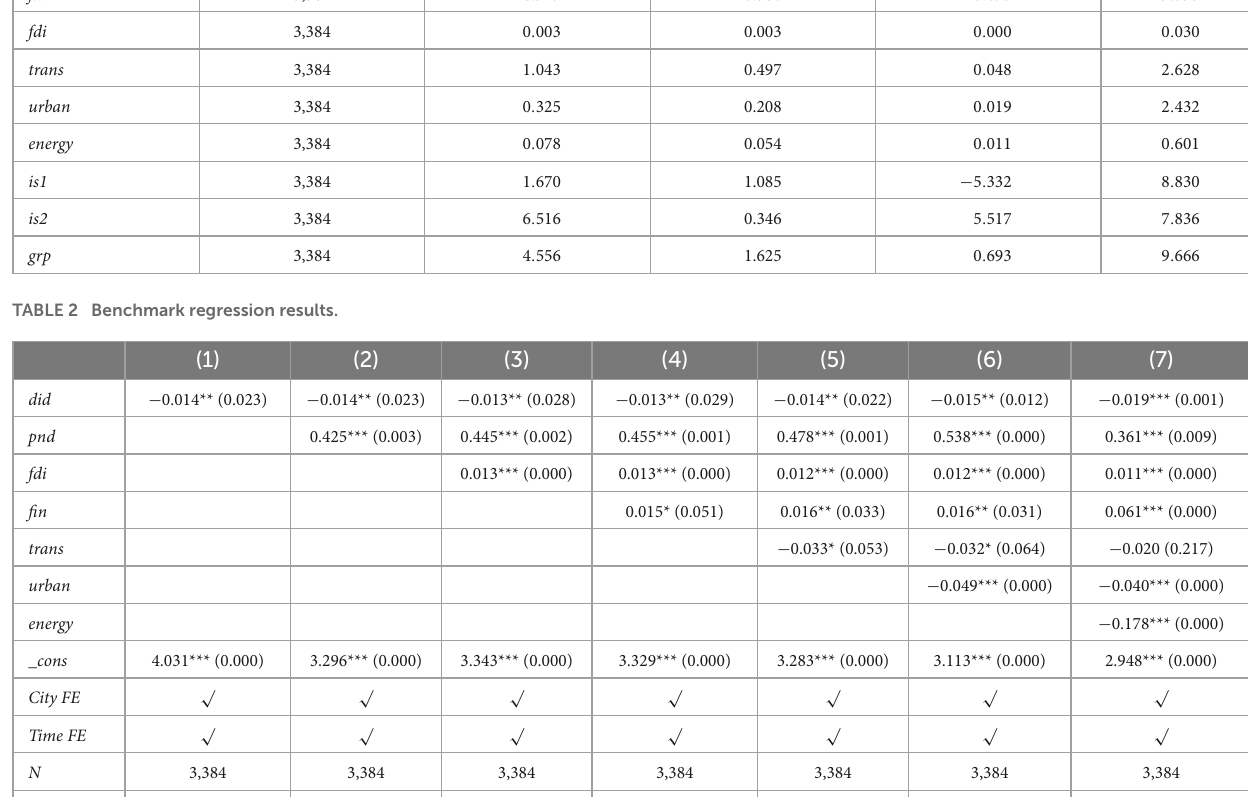
TABLE 1 Descriptive statistics of variables.